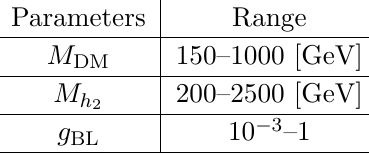
Table 2 . Parameters varied in generating the scatter plot near the h 2 resonance